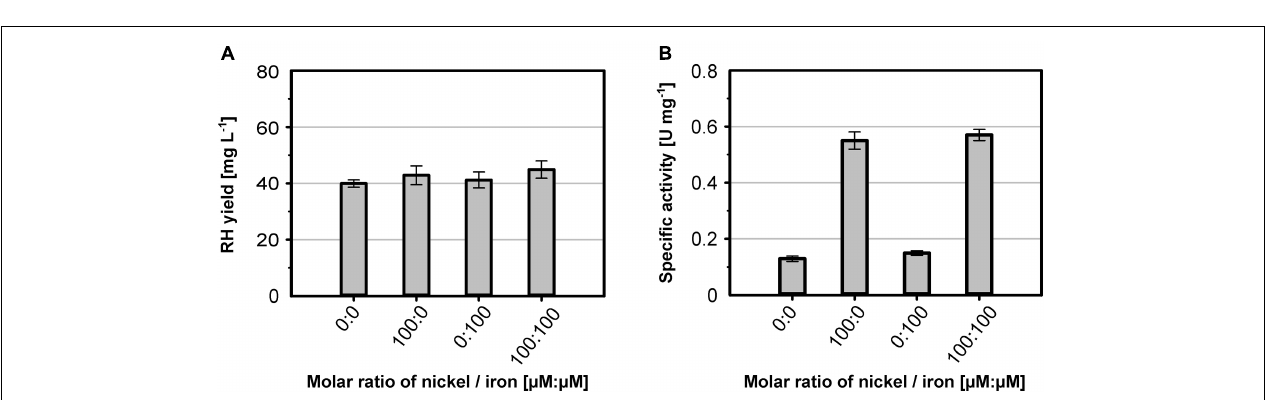
FIGURE 4 | Effect of the Ni and Fe concentration on cell growth and RH activity. E. coli strain MQF8RH3 was cultivated in 24-deepwell plates with 8 mL boosted EnPresso medium at 30 ◦ C under O 2 -limited conditions. NiCl 2 or FeSO 4 were supplemented using the indicated concentrations varying from 0 to 2.0 mM. Cells were harvested 24 h after induction with 50 µ M IPTG. (A) Optical density of the cell culture just before harvesting. (B) Soluble extracts were obtained by sonication and RH activity was measured. The specific RH activity was calculated based on the RH concentrations determined in the crude extracts by Western blotting ( Supplementary Figure 4 ).